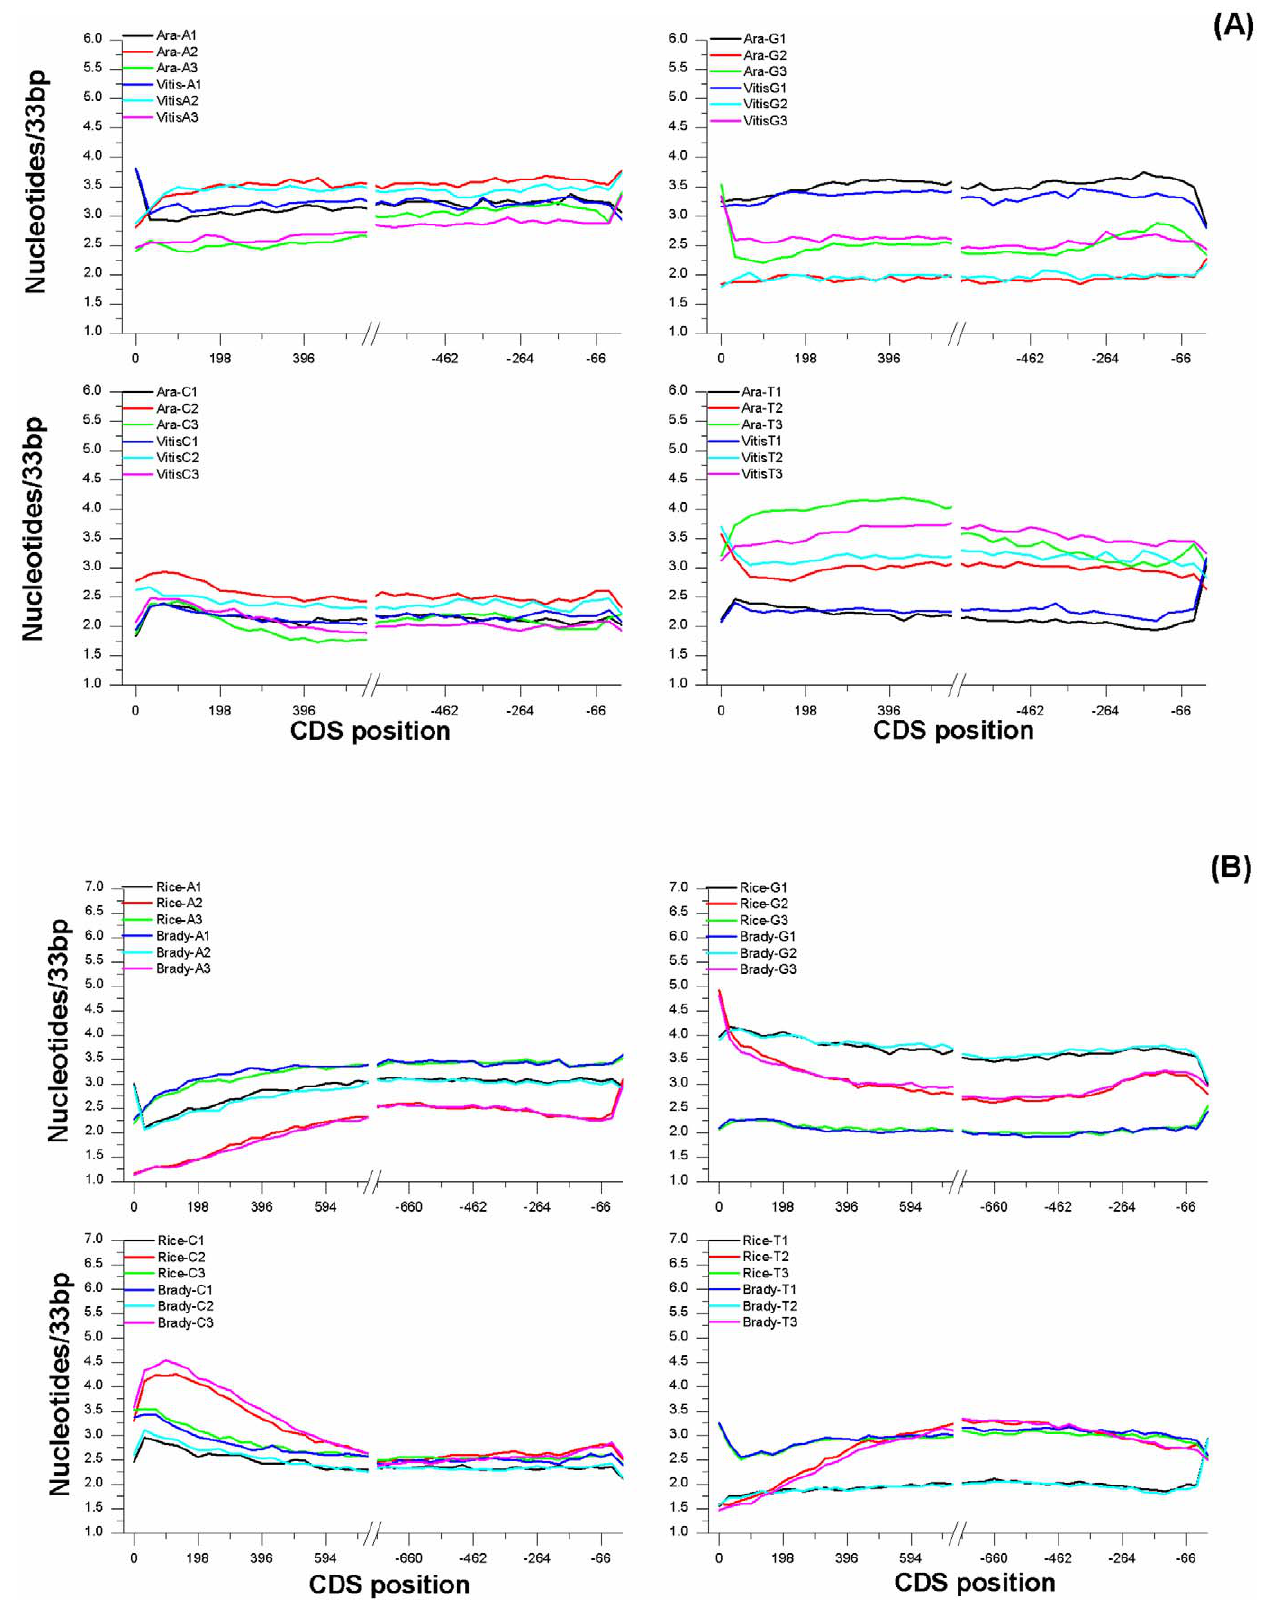
Figure 2. Contribution of the three nucleotide codon positions. Overall first, second and third codon nucleotide content as function of position in eudicots(a) and monocots(b) coding sequences and averaged over all sequences in the dataset with a 33 bp adiacent window. doi:10.1371/journal.pone.0022855.g002 PLoS ONE | www.plosone.org